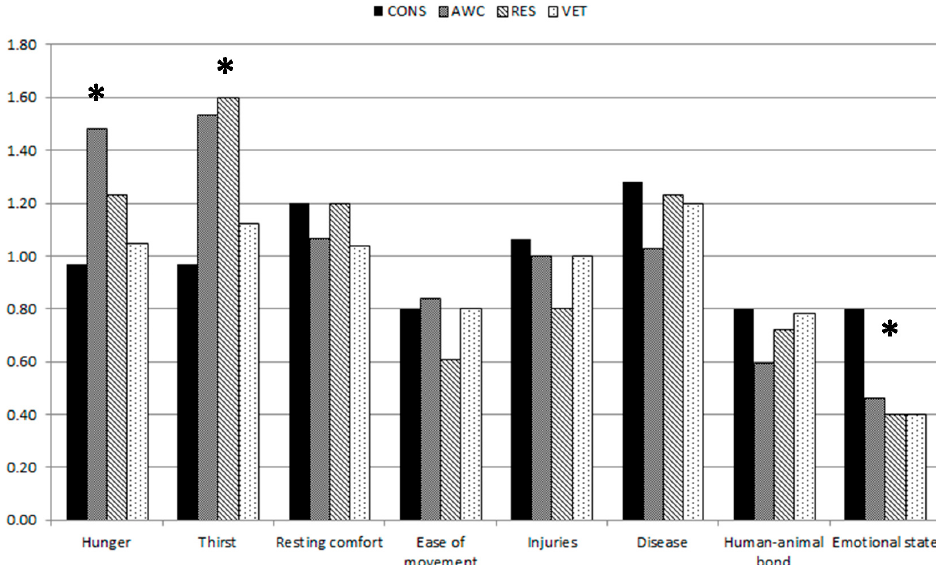
Figure 2. Median expert weights for welfare criteria given by four different Danish cattle expert groups, production advisors/consultants (CONS), animal welfare control officers (AWC), animal welfare researchers (RES) and bovine veterinarians (VET) in two online surveys (2011, 2016). Significant differences between groups are marked with an asterix (significance level * p < 0.05).